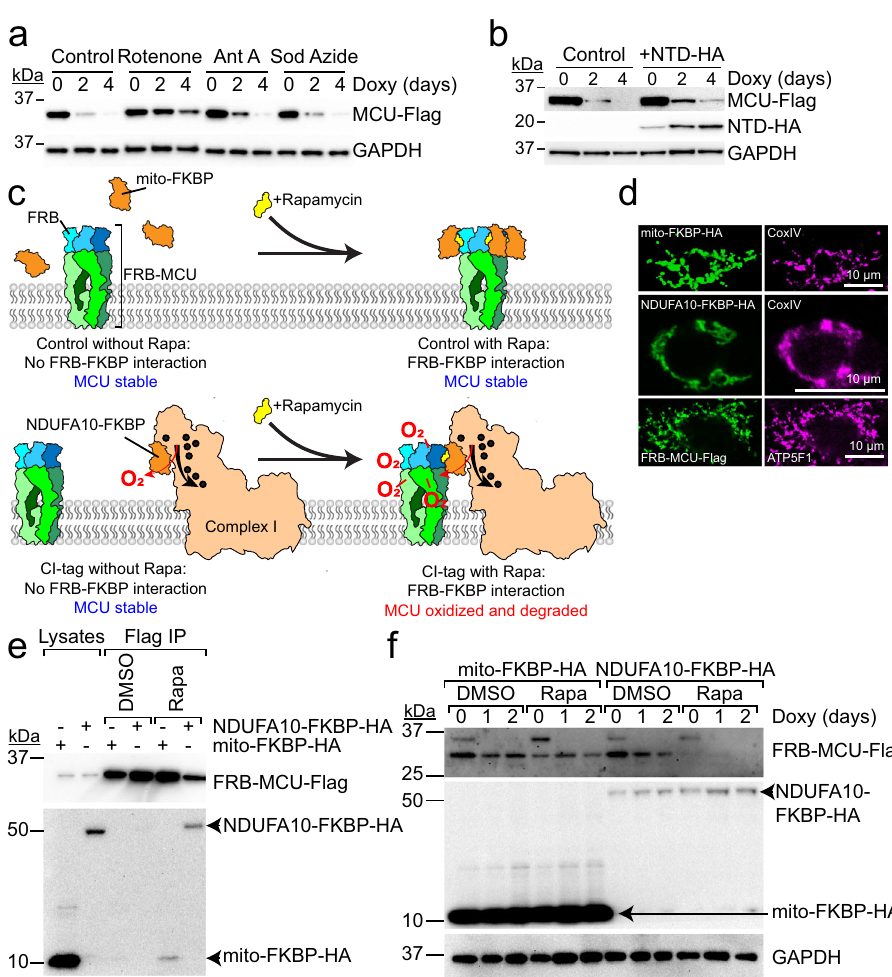
Fig. 4 CLIPT controls MCU degradation. a Doxycycline (doxy) treatment represses transcription of MCU-Flag. MCU-Flag persists after Complex I inhibition (rotenone) but not Complex III (antimycin A) or IV (sodium azide). b MCU-Flag stabilization induced by NTD peptide. c Design of rapamycin (Rapa)-induced dimerization experiment to test if MCU-Complex I interactions dictate MCU degradation. d Immunocytochemistry reveals co-localization of FRB-MCU, NDUFA10-FKBP, and mito-FKBP with mitochondrial markers CoxIV or ATP5F1. e With replacement of NTD with FRB, MCU only binds FKBP- tagged NDUFA10 in the presence of 100 nM rapamycin. Mito-FKBP-HA is a control. f FRB-MCU is stable in the absence or presence of rapamycin when cells co-express mito-FKBP-HA control, but rapidly degraded when rapamycin induces Complex I-binding in NDUFA10-FKBP-HA expressing cells. Images are representative of 3 ( a , b , f ) or 2 ( d , e ) separate trials. Source data are provided as a Source Data fi